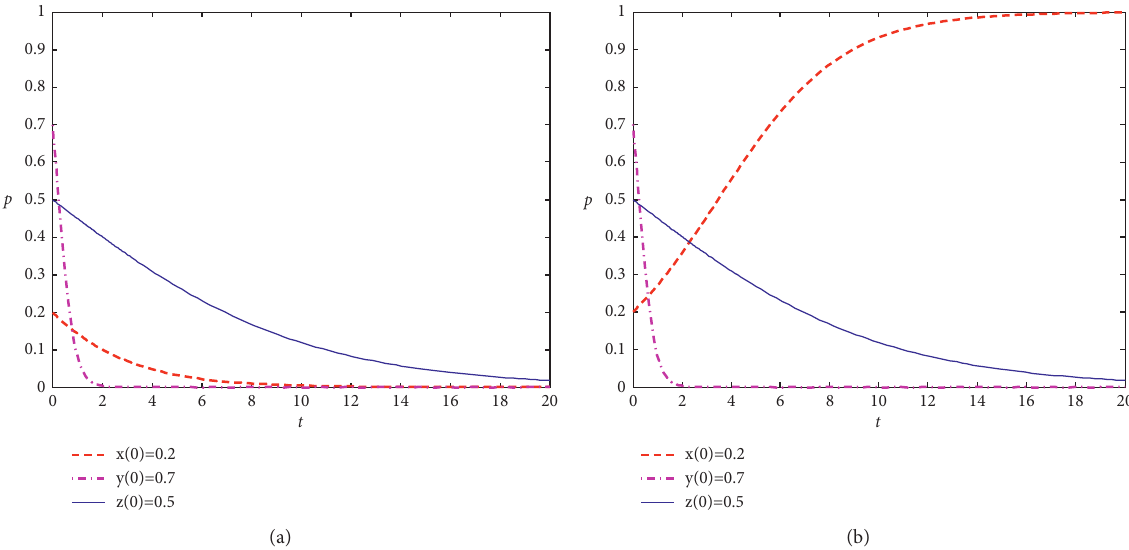
Figure 8: The impact of the costs of strict supervision and the damage caused by general supervision on evolutionary results. (a) C E � 0.1. (b) C 1 � 0.6, and E �